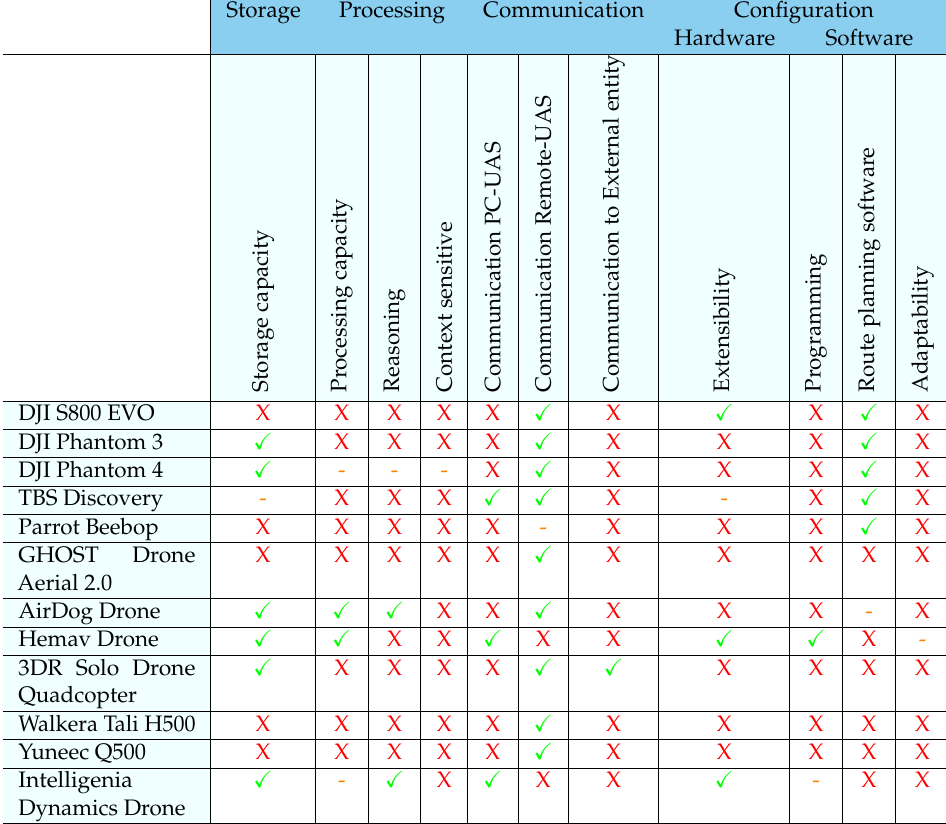
Table 5. Matching between features and commercial UAS. Storage Processing Communication Configuration